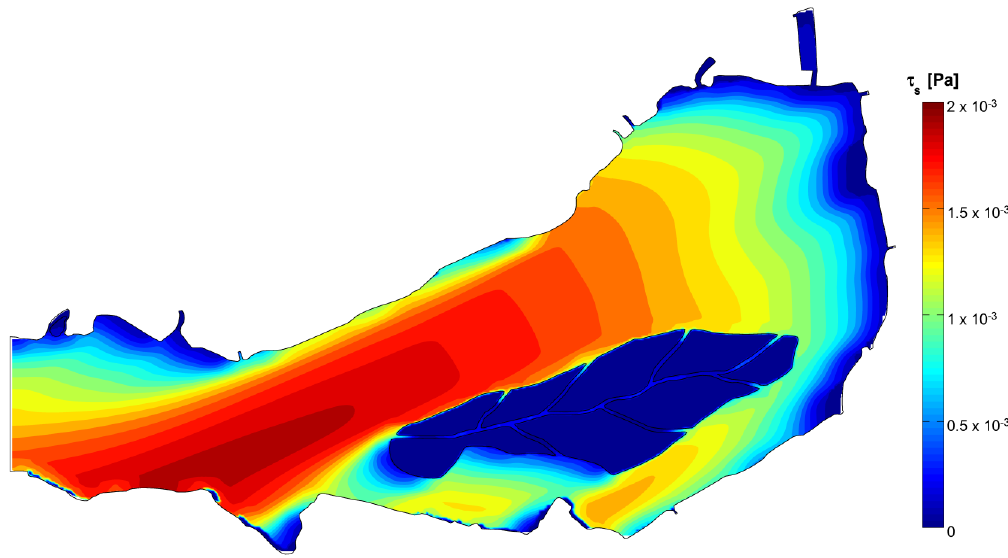
Figure 4. Wind stress field for the CHRIS-PROBA 29 June 2008